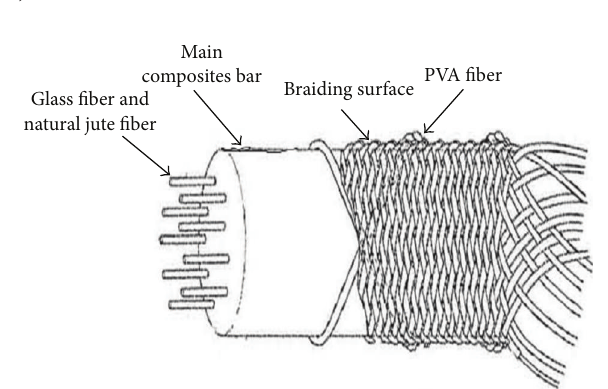
Figure 1: Braiding surface of HGJFRP composite bars in this